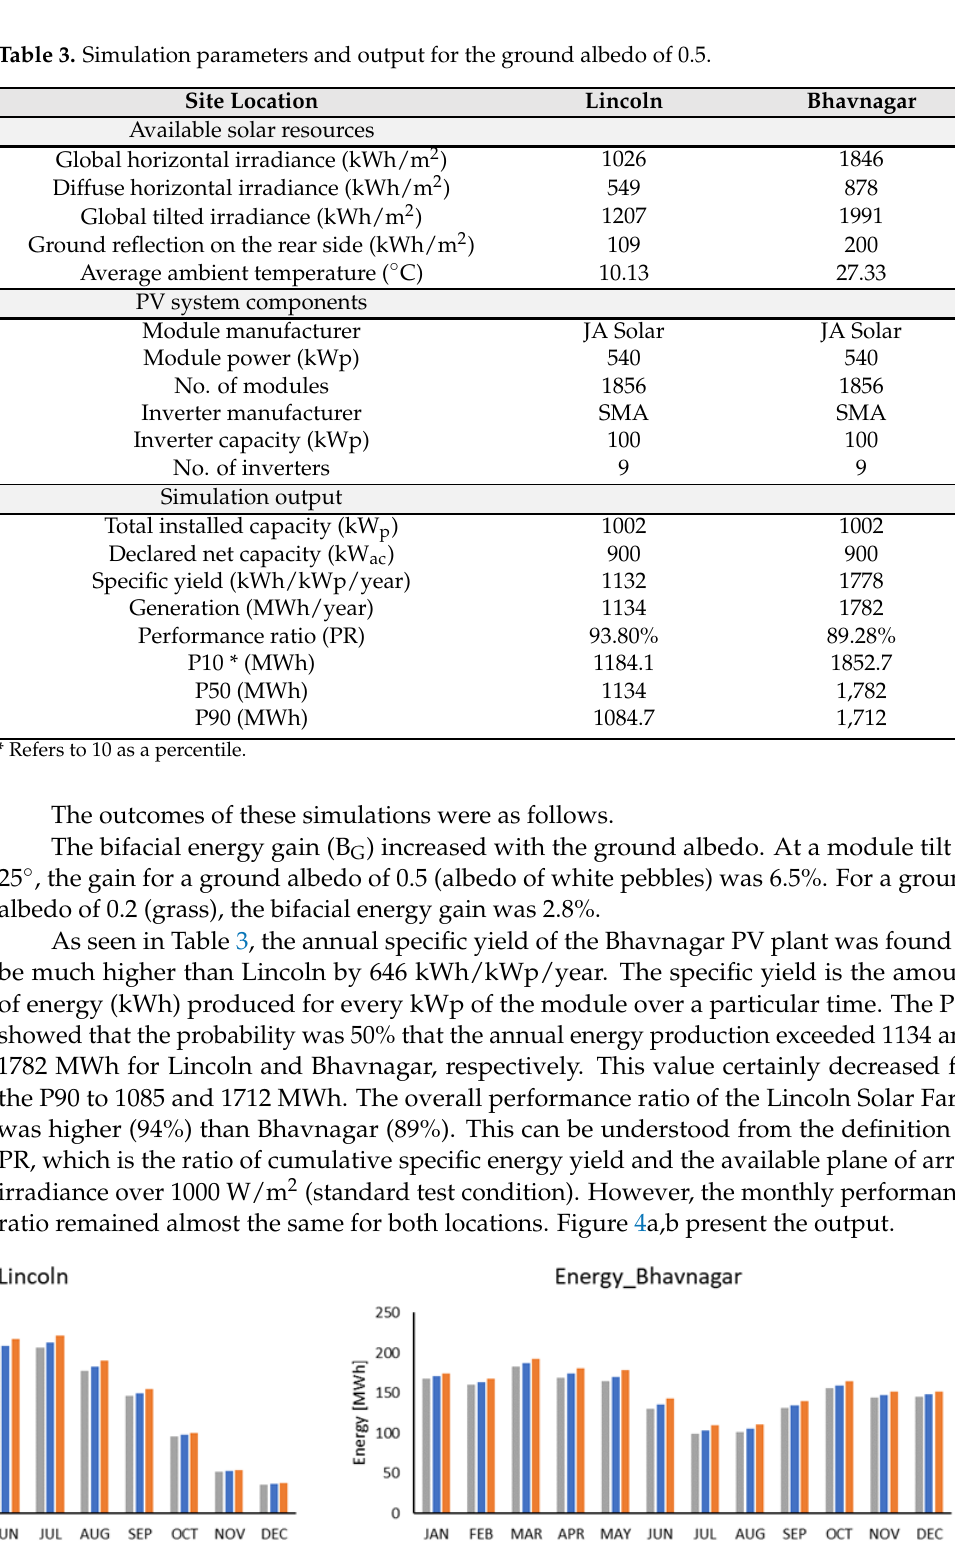
( b ) Figure 5. Monthly performance ratio of the ( a ) Lincoln Solar Farm and ( b ) Bhavnagar Solar Farm. 6. Economic Assessment In an attempt to compare the economics of monofacial versus bifacial modules, a PV industry analyst, namely, R Balyon, presented a report called LCOE of Monofacial vs Bifacial Modules: Are Bifacials Worth the Extra Cost? [33]. The above article mentioned that bifacials have a higher energy yield of 6% to 10% compared with traditional monofacial modules. Table 4 presents the analysis of Balyon. We note that the capital cost of bifacial modules is only 3.3% higher and the levelised cost of energy 0.9% lower for the bifacial-module-based power plant. Table 4. Economic comparison of Bifacial against monofacial PV power plants. Monofacial